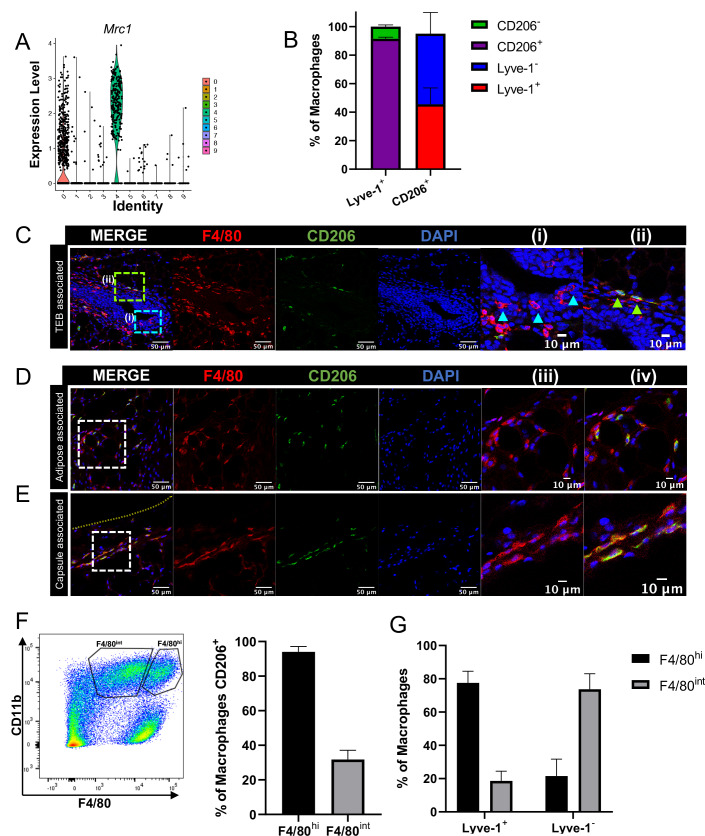
F4/80+Lyve-1+ cells are enriched for CD206 expression.(A) Violin plot of Mrc1 expression in the single-cell RNA-seq dataset shown in Figure 2. (B) Mammary glands from 10-week-old mice (n = 4) were assessed for CD206 expression in CD45+CD11b+F4/80+Lyve-1- and CD45+CD11b+F4/80+Lyve-1+ cells by flow cytometry. (C) Mammary glands were harvested from 6-week-old mice (n = 5, three images/localization), immunostaining was performed for F4/80 and CD206, and the localization of single- and double-positive cells associated with TEBs was examined. Representative images of F4/80+CD206– (i, arrowheads) and F4/80+CD206+ (ii, arrowheads) cells are shown. (D, E) Representative images of F4/80+CD206+ cells in the adipose stroma and fibrous capsule of the mammary gland. Representative images show F4/80 (iii) and co-staining (iv). The yellow line in panel (E) shows the margin of the mammary gland. Insets show higher magnification. (F) Flow cytometry analysis showing F4/80hi and F4/80int cells in the mammary gland and CD206 expression in each population. (G) Flow cytometry analysis of F4/80 expression on Lyve-1– and Lyve-1+ cells. n = 4 mice analyzed.Figure 3—source data 1.Source data for graphs in panels B, F, and G.